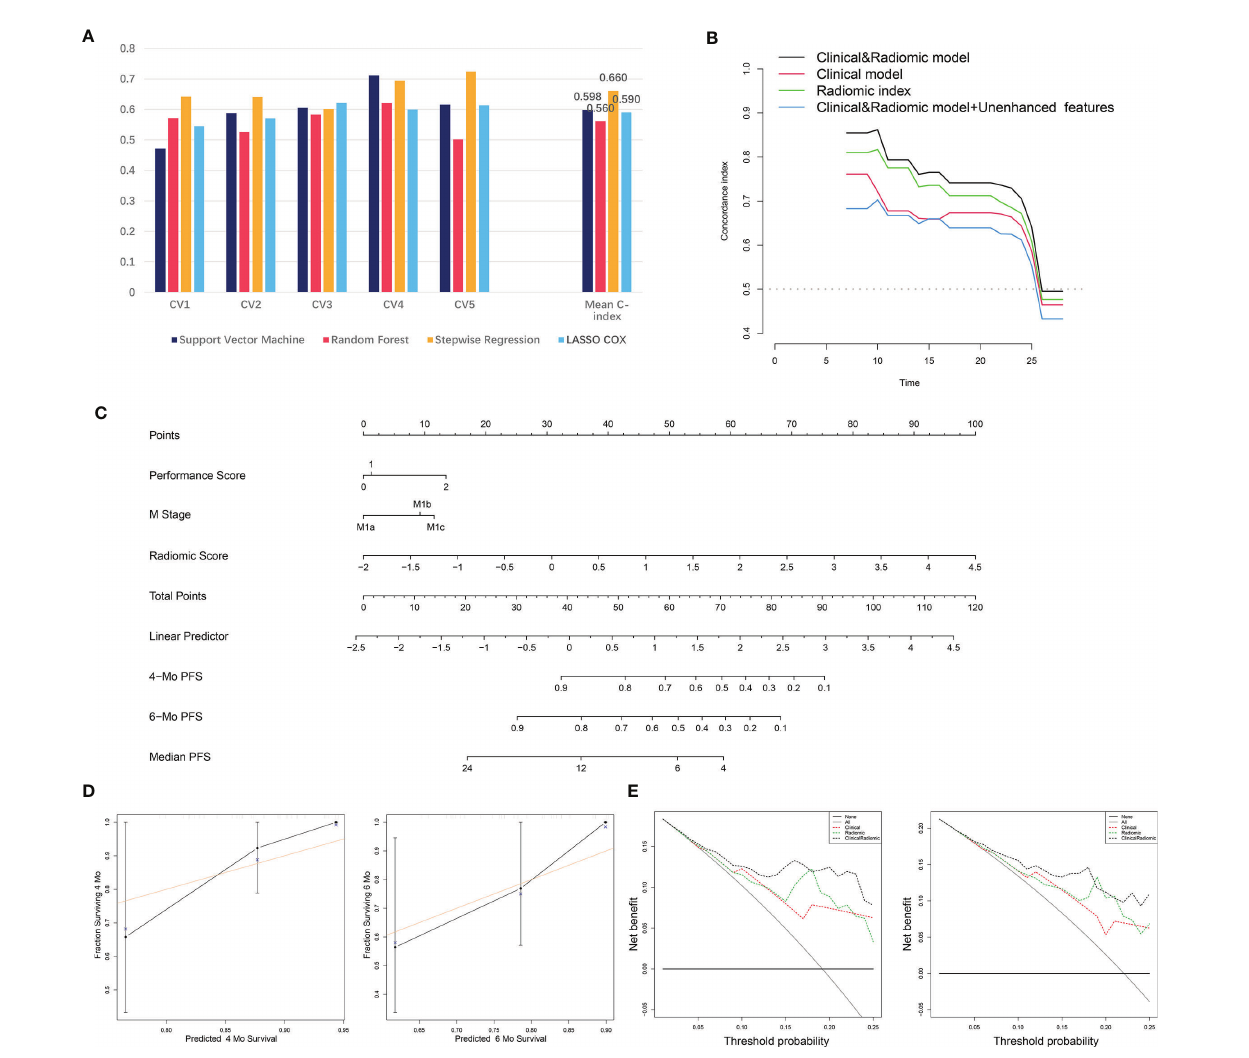
FIGURE 4 | The development and validation of the radiomic and clinical and radiomic model. (A) Comparison of C-index of different machine learning methods in the 5-fold cross-validation. (B) C-index of the radiomic, clinical and clinical and radiomic model at distinct time points. (C) Visualizing of the clinical and radiomic model by nomogram. (D) Validation of the clinical and radiomic model by DCA. (E) Validation of the clinical and radiomic model by calibration curve analysis. C-index, Concordance index; DCA, Decision curve analysis.